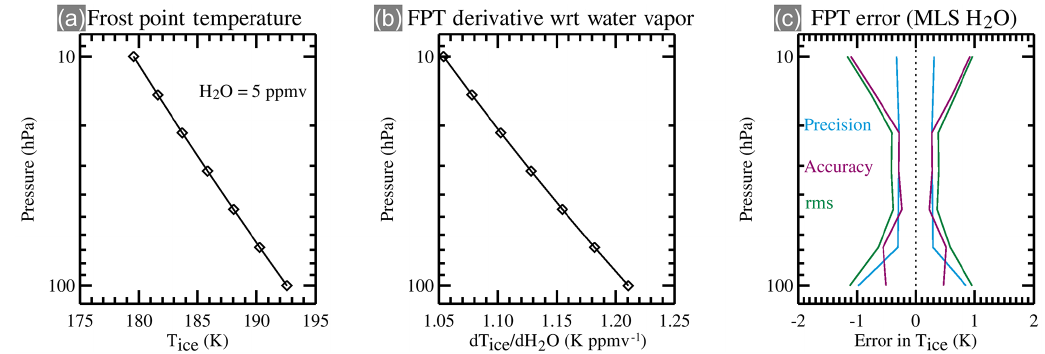
Figure 1. (a) Variation of frost point temperature with pressure in the lower stratosphere for a fixed H 2 O volume mixing ratio (5ppmv). (b) Derivative of the frost point temperature with respect to water vapor. (c) Error in determination of frost point temperature ( T ice ) arising from the uncertainties in the MLS H 2 O